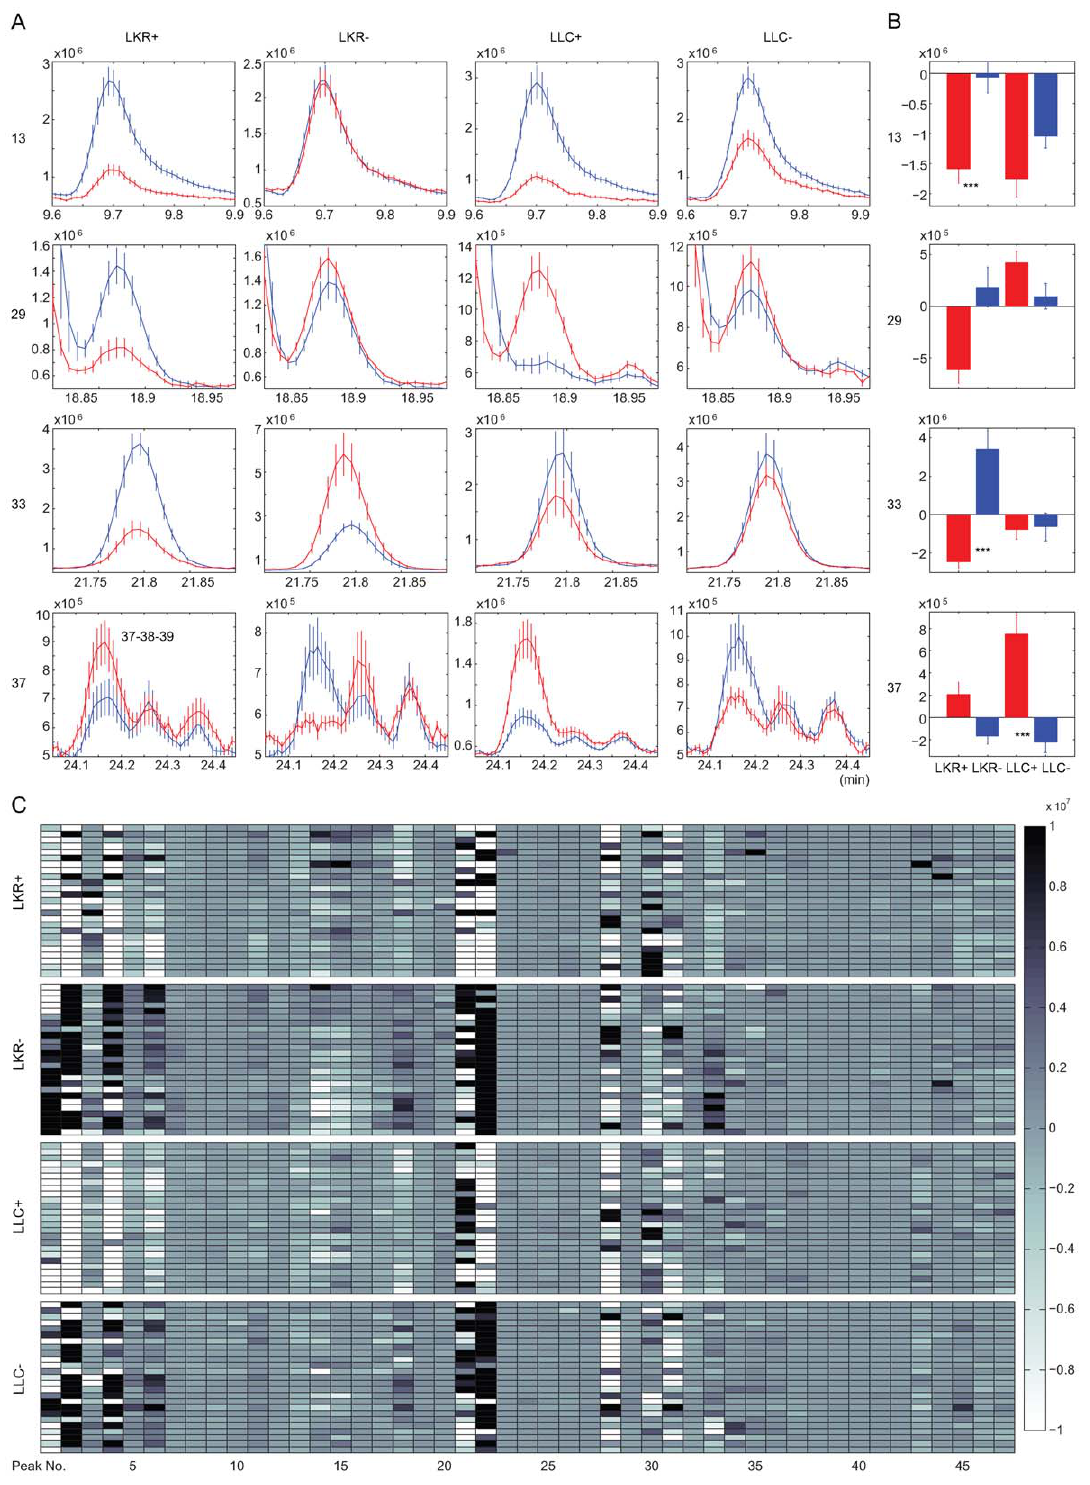
Figure 2. Comparison of selected peaks. (A) Comparison between early stage and late stage of 4 illustrative peaks selected from 47 peaks analyzed. Vertical axis indicates intensity (amount) of TIC; vertical lines around mean indicate SEM at each sampling point. Blue represents early stage whereas red represents late stage. Horizontal axis indicates retention time. (B) Bar plot of intensity of 4 illustrative peaks selected from the 47 peaks analyzed. Mean peak intensity is plotted at each peak. Red bars represent tumor groups; blue bars represent control groups. A pale blue background indicates a significant difference at P , 0.0001 between tumor and control groups. (C) Raw intensity of 47 analyzed peaks obtained by subtracting the early period from the later period (n=25 for each of the 4 groups). Darker grey means the peak increased following tumor development whereas the lighter grey means the peak decreased following tumor development.